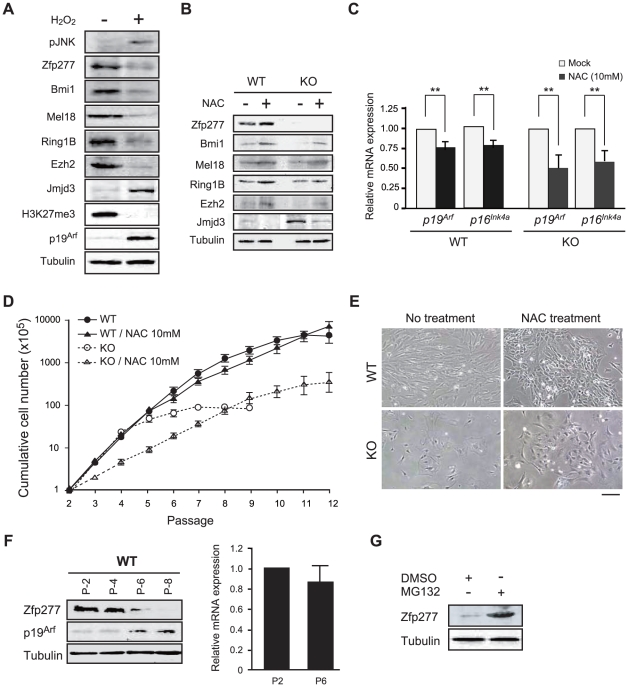
Oxidative stress leads to down-regulation of Zfp277.
A. H2O2 treatment of MEFs. The whole-cell extract from wild-type MEFs treated with 100 mM H2O2 for 6 hrs was subjected to a Western blot analysis for the proteins indicated on the left. B. N-acetyl cysteine (NAC) treatment of MEFs. Wild-type and Zfp277
−/− MEFs (P-2) were cultured in the presence of 10 mM NAC. MEFs were harvested at passage 6 and the levels of Zfp277 and PcG proteins were determined by Western blotting. Tubulin was used as a loading control. C. Quantitative RT-PCR analysis of p19Arf and p16Ink4a mRNA in wild-type and Zfp277
−/− MEFs at passage 6 cultured in the presence of 10 mM NAC. mRNA levels were normalized to Hprt1 expression. Expression levels relative to those in wild-type MEFs without NAC treatment are shown as the mean ± SD for three independent experiments. D. NAC treatment rescues the growth of Zfp277
−/− MEFs. Wild-type and Zfp277
−/− MEFs were cultured with or without 10 µM NAC and cell growth was monitored every three days by replating at 1×105 cells/plate. Cumulative cell numbers are shown as the mean ± SD for three independent triplicate experiments. E. Photomicrographs of wild-type or Zfp277
−/− MEFs with or without NAC observed under an inverted microscope. Scale bar represents 200 µm. F. Expression of p19Arf in Zfp277
−/− MEFs. The protein levels of p19Arf in wild-type MEFs at the indicated passages were determined by Western blot analyses (left panel). Tubulin was used as a loading control. Quantitative RT-PCR analysis of p19Arf mRNA in wild-type MEFs at passages 2 and 6 (right panel). mRNA levels were normalized to Hprt1 expression. Relative expression levels are shown as the mean ± SD for three independent experiments. G. MG132 treatment of MEFs. MEFs at passage 4 were treated with 10 µM MG132 for 6 hrs and Zfp277 protein levels were determined by Western blotting. Tubulin was used as a loading control. Statistical significance was determined with Student's t-test; **p<0.01.